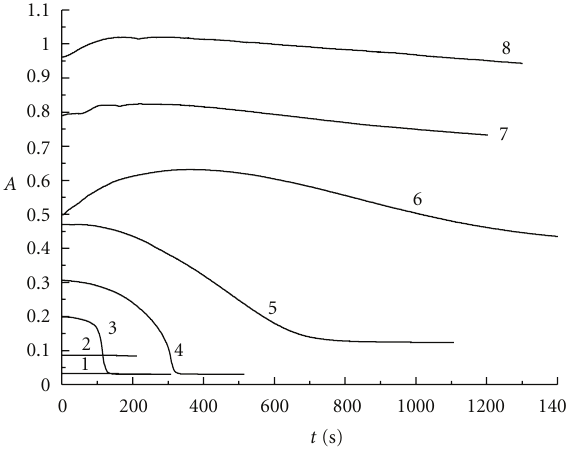
Figure 4: The absorbance versus reaction time at 350 nm for triiodide ion: curve 1: r = 1 . 05; curve 2: r = 2 . 03; curve 3: r = 3 . 00; curve 4: r = 3 . 95; curve 5: r = 4 . 85; curve 6: r = 6 . 00; curve 7: r = 7 . 00; curve 8: r = 8 .